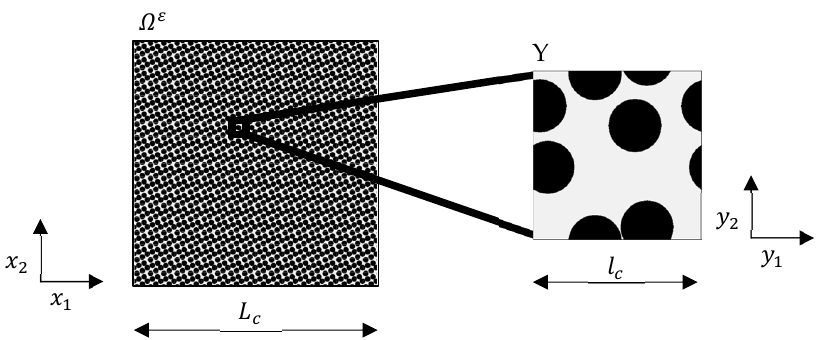
Figure 4. Fibrous media that is composed of spatially periodic RVE. The RVE consists of randomly arranged circles representing the fibers in two dimensions.